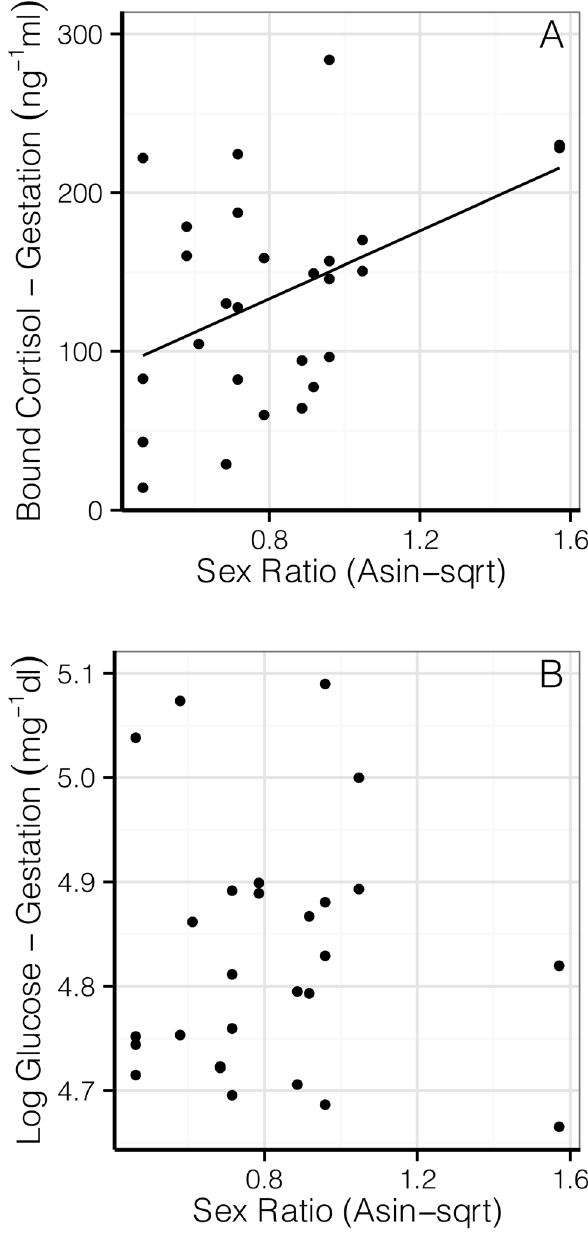
Figure 2. Relationship between bound maternal gestational cortisol (A) and glucose (B) during gestation and sex ratio. Both graphs show multiple points for each individual, accounted for using mixed effects models with individual identity as a random factor. The relationship between bound cortisol and sex ratio was significant ( P =0.030), while glucose was not correlated with sex ratio in this study ( P =0.836).